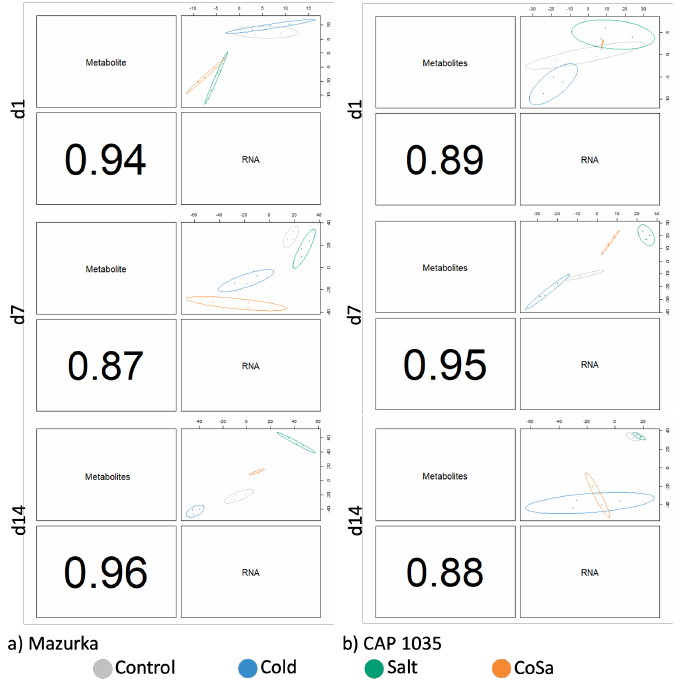
FigureA14. OverviewDIABLO. Aglobaloverviewofthecorrelationstructureatthecomponentlevel Figure A14. Overview DIABLO. A global overview of the correlation structure at the component level foreachgroupaccordingtotheharvesttimepoint. Allcomponentsacrossthedifferentdatasetsfora for each group according to the harvest time point (data for Mazurka is shown in ( a ) and for CAP1035 givendimensionareplotted. Differentcolorsrepresentdifferenttreatments: control=grey,cold=blue, salt=green,CoSa=orange. in ( b )). All components across the different data sets for a given dimension are plotted. Different colors represent different treatments: Control = grey, Cold = blue, Salt = green, CoSa = orange. Version March 28, 2022 submitted to Antioxidants